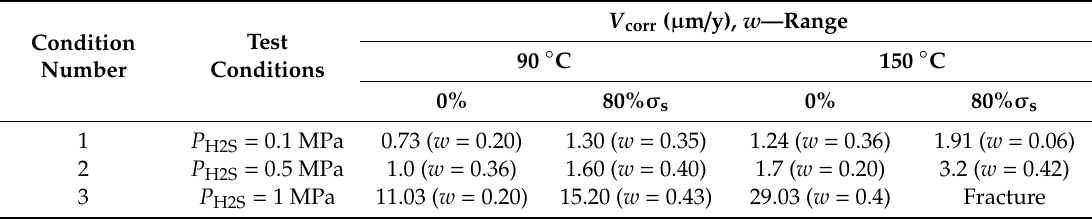
Table 1. The average corrosion rates of samples under high-temperature and